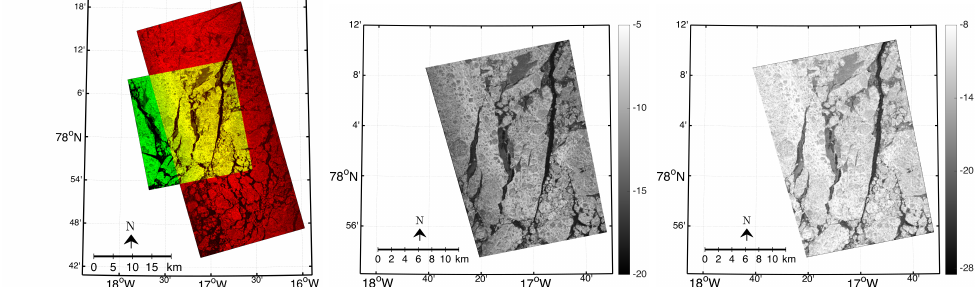
Figure 3. The left RGB image (scaled) of scene pair P 2 , where the green band is the VV-intensity from RS-2 scene and red is the RV-intensity from RI-1 scene. Yellow indicates areas of overlap. The center (right) image is the RV (VV)-intensity of the overlapping area from RI-1 (RS-2). RS-2 Data and Products